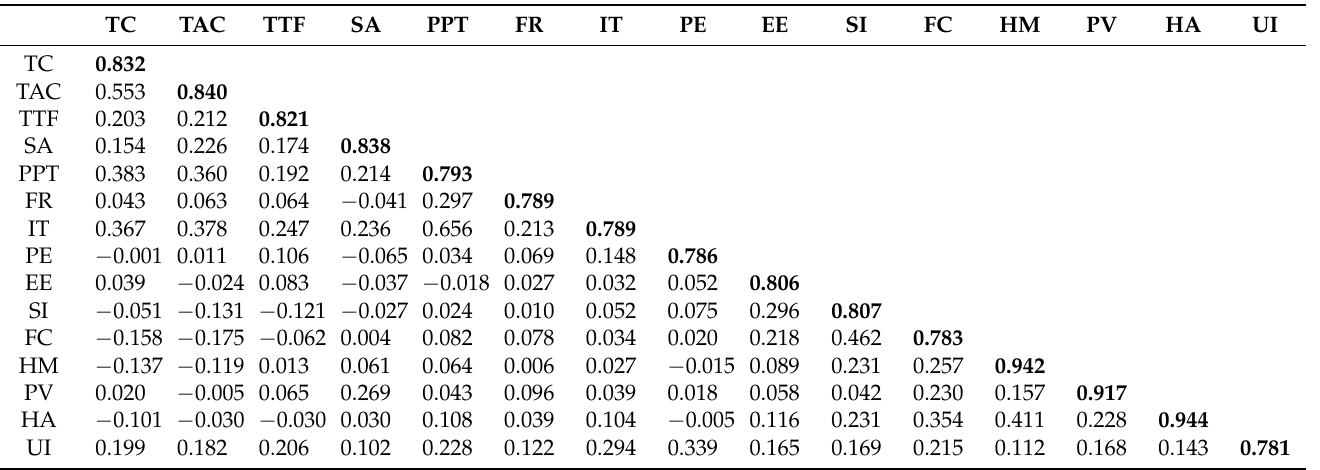
Table 4. Fornell–Larcker criterion discriminant validity (in bold numbers).